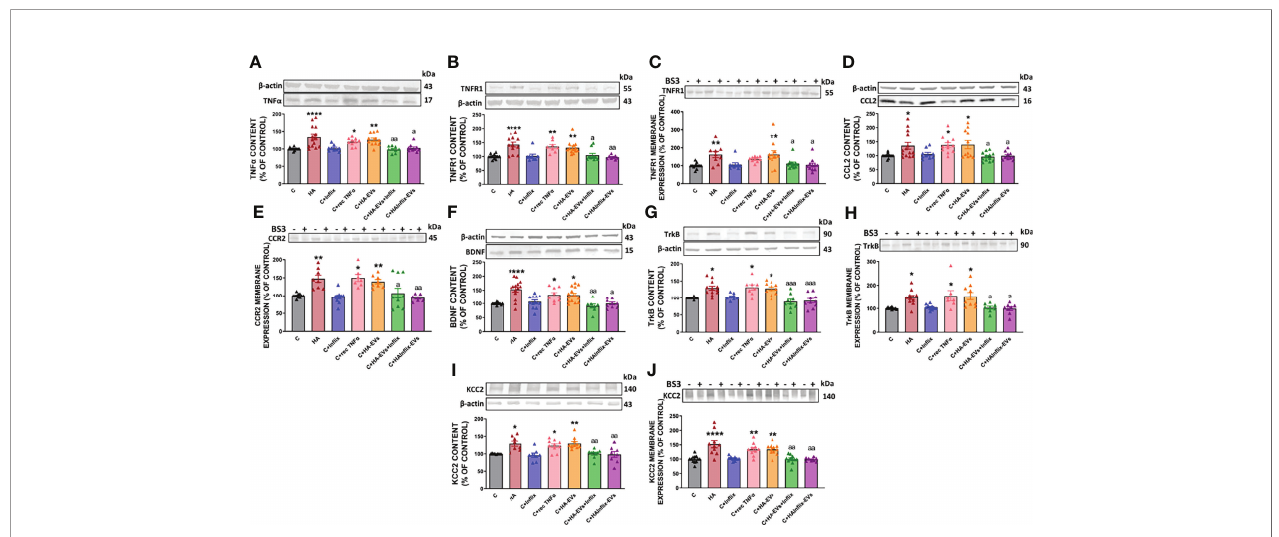
FIGURE 3 | Extracellular vesicles from hyperammonemic rats activate CCL2-CCR2-TrkB-KCC2 pathway in cerebellar slices from control rats. Protein content of (A) TNF a (n=9-14), (B) TNFR1 (n=8-13), (D) CCL2 (n=9-14), (F) BDNF (n=9-15), (G) TrkB (n=8-12) and (I) KCC2 (n=8-10) measured by Western blot in cerebellar slices. Membrane expression of (C) TNFR1 (n=9-13), (E) CCR2 (n=7-11), (H) TrkB (n=7-11) and (J) KCC2 (n=8-12) measured by Western blot in cerebellar slices incubated with or without BS3. Sample size indicates number of animals. Representative images of Western blot bands and loading control are shown and molecular weight of each protein is indicated. Values are expressed as percentage of control and are the mean±SEM. Values signi fi cantly different from controls are indicated by asterisk (*p<0.05, **p<0.01, ****p<0.001) and values signi fi cantly different from C+HA-EVs group are indicated by a (a = p<0.05, aa = p<0.01, aaa = p<0.001).